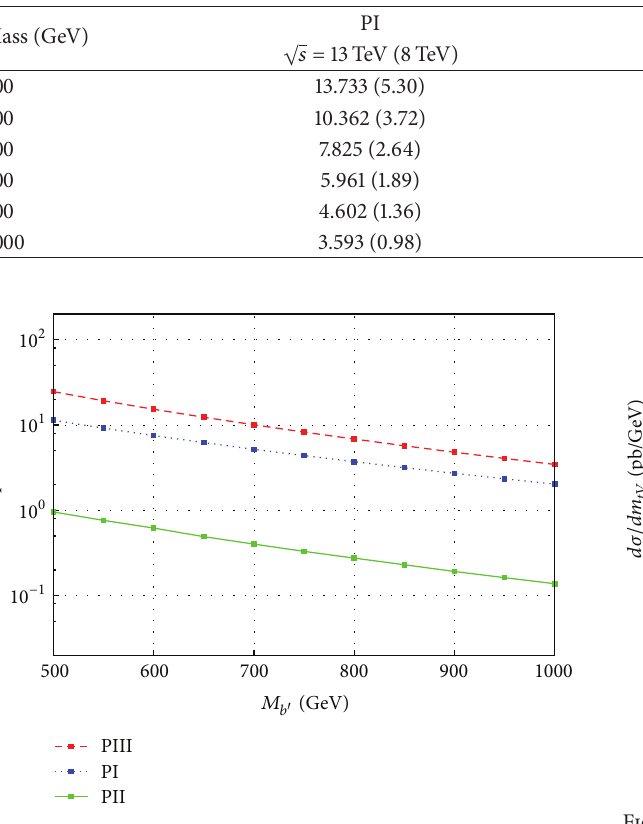
Figure 3: The cross section for the process 𝑝𝑝 → 𝑏𝑉+𝑋 depending on the new heavy quark mass for parameter sets PI, PII, and PII at the center of mass energy √𝑠 = 13 TeV.